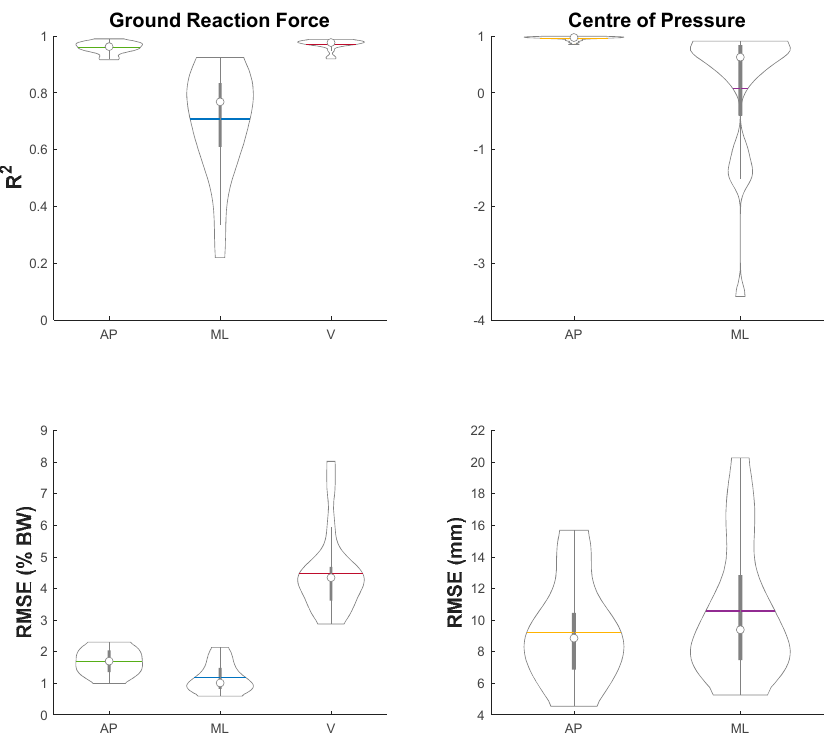
Figure 3. Distribution of R 2 ( top row ) and RMSE ( bottom row ) for GRF ( left column ) and COP ( right column ) for all the trials. RMSE for GRF and COP in % BW and in mm, respectively.